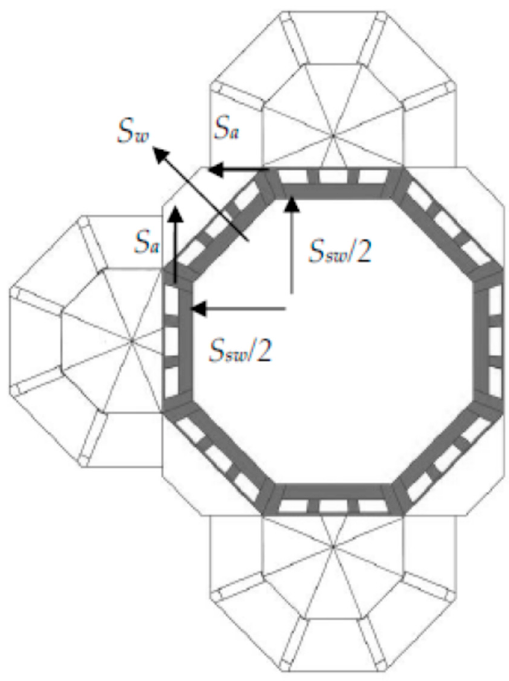
Figure 12. Composition of thrusts acting on the single pillar.